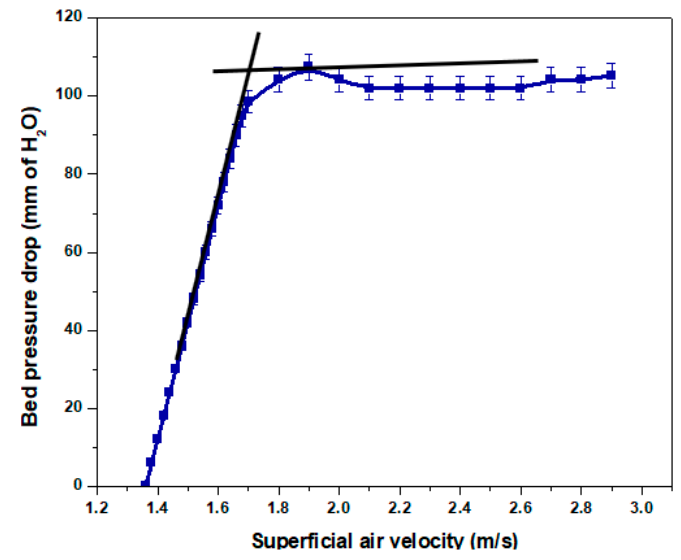
Figure 8. Pressure drop curve for estimation of minimum fluidization velocity.